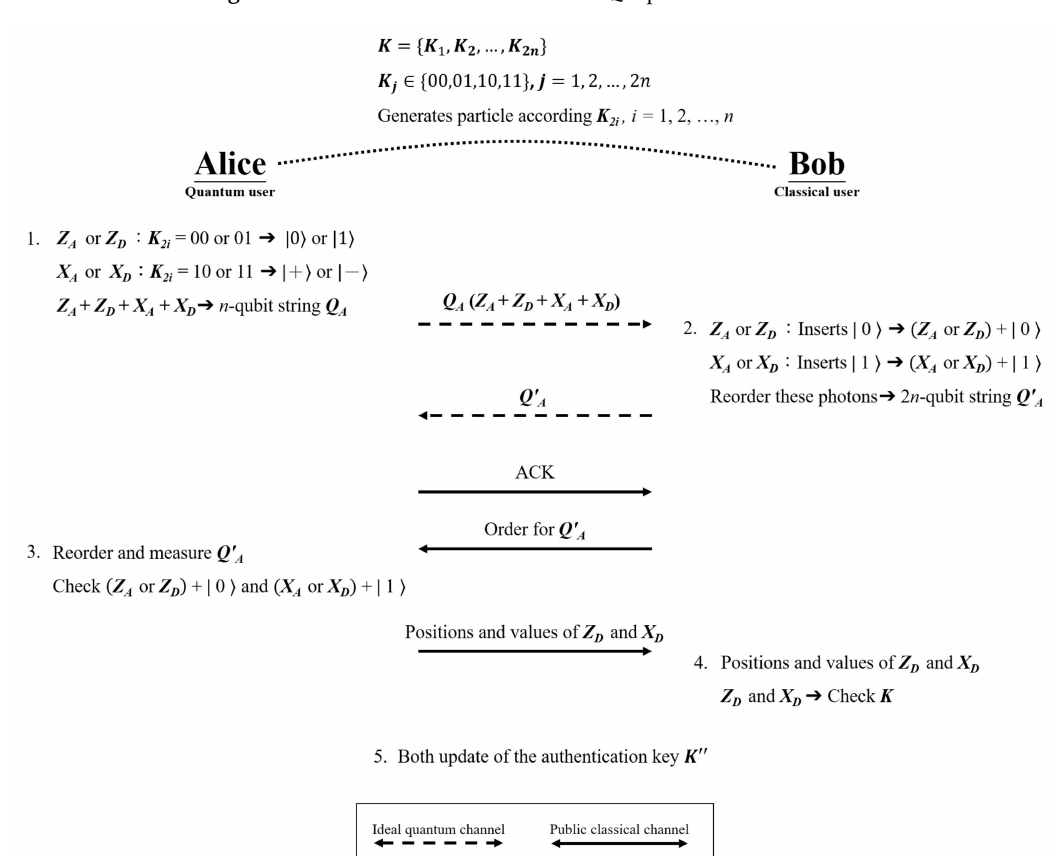
Figure 2. Zhou et al.’s measurement-free SQA